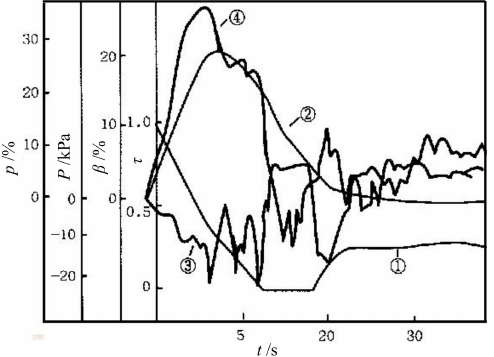
Figure 4. Transient process of a hydropower plant with an SCTT under the two-stage closing law of guide vanes